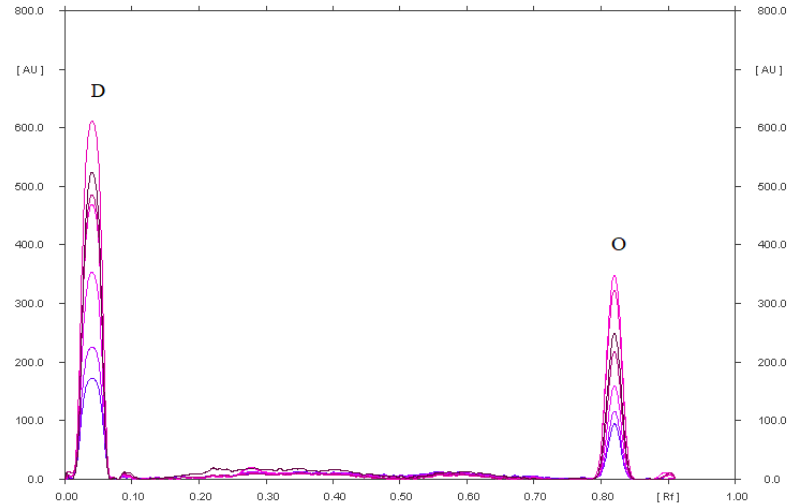
Figure 5. Densitogram of DicloDuo Combi extract, which was separated on silica gel using a mobile phase: chloroform–methanol–ammonia (36:4:0.60, v / v / v ); where: D-diclofenac sodium (3.38 µ g), O-omeprazole (0.90 µ g).